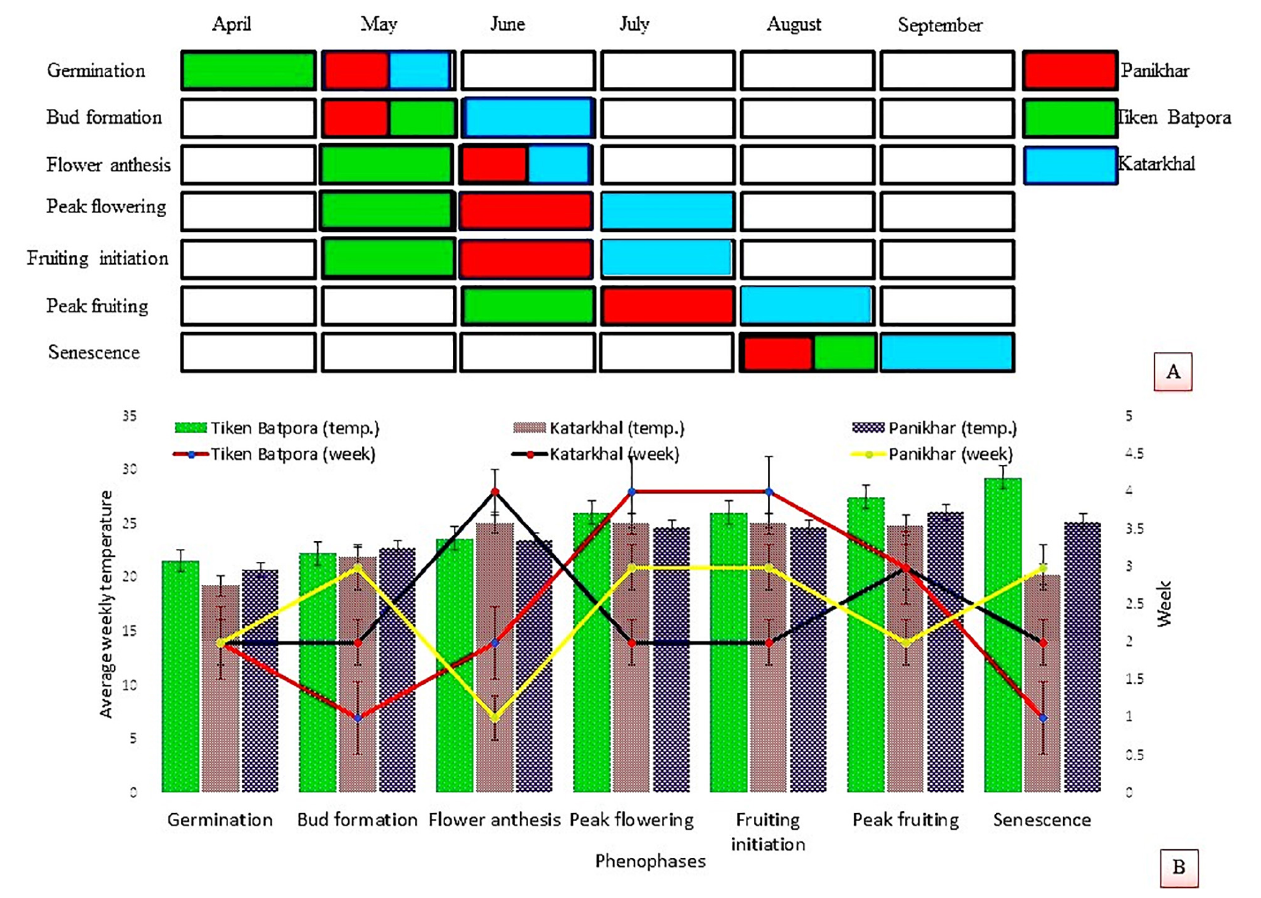
FIGURE 1 | (A) Phenophases of Rheum webbianum at in situ and ex situ populations. (B) Response of different phenophases to average weekly temperature and time periods.